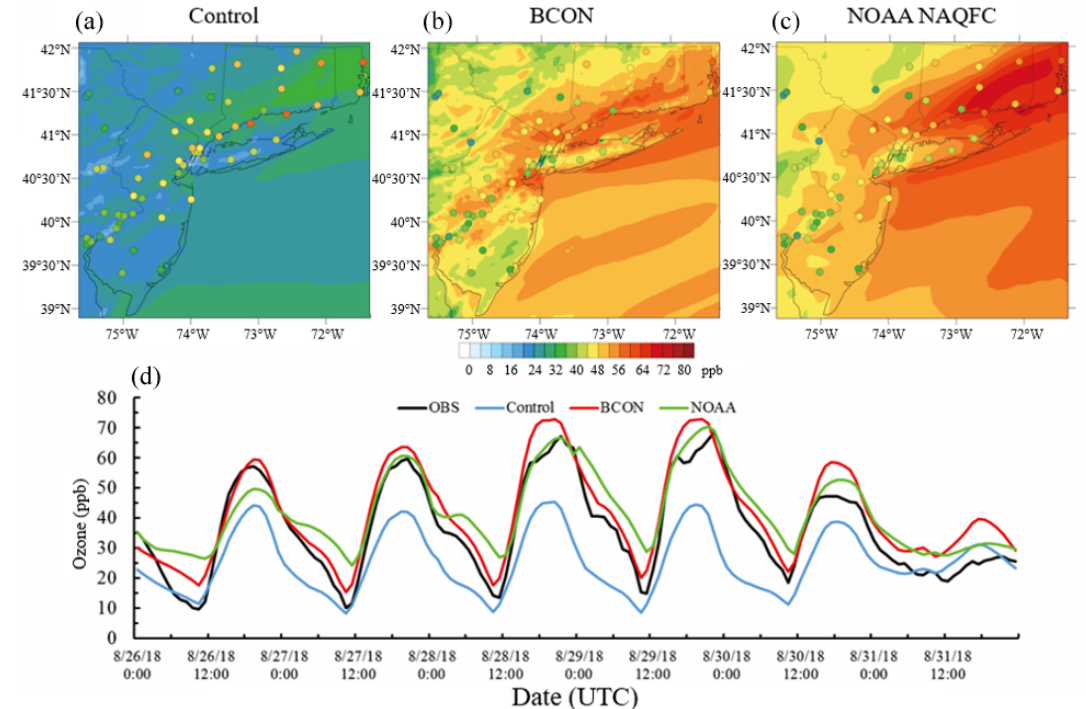
Figure 2. Predicted O 3 concentrations from (a) Control, (b) BCON and (c) NOAA NAQFC simulations on 29 August 2018 and (d) compar- ison of domain-averaged hourly O 3 concentrations with EPA AirNow measurements during this episode. Colored circles in the top panels depict the observed concentrations from ground measurements.